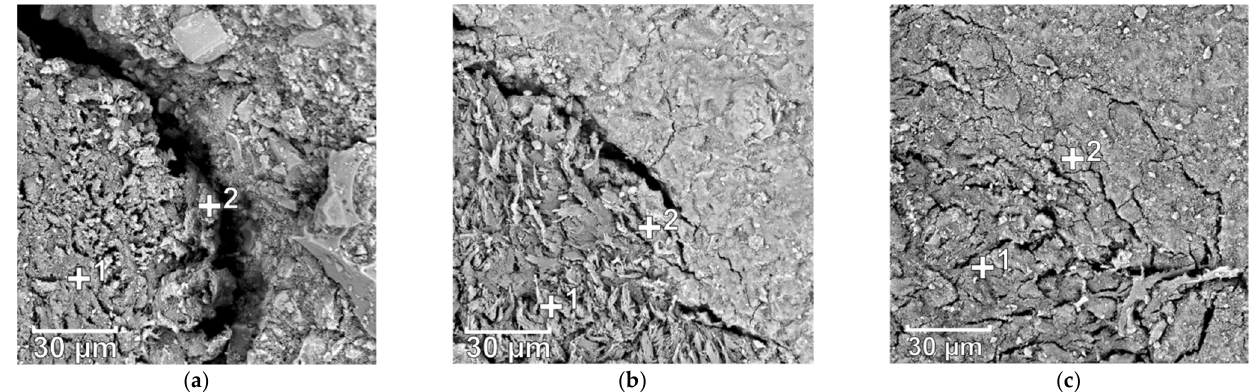
Figure 8. ITZs (Interfacial Transition Zones) with ( a ) raw coir fibers, ( b ) Ca(OH) 2 treated fibers, and ( c ) Nano-silica treated fibers.